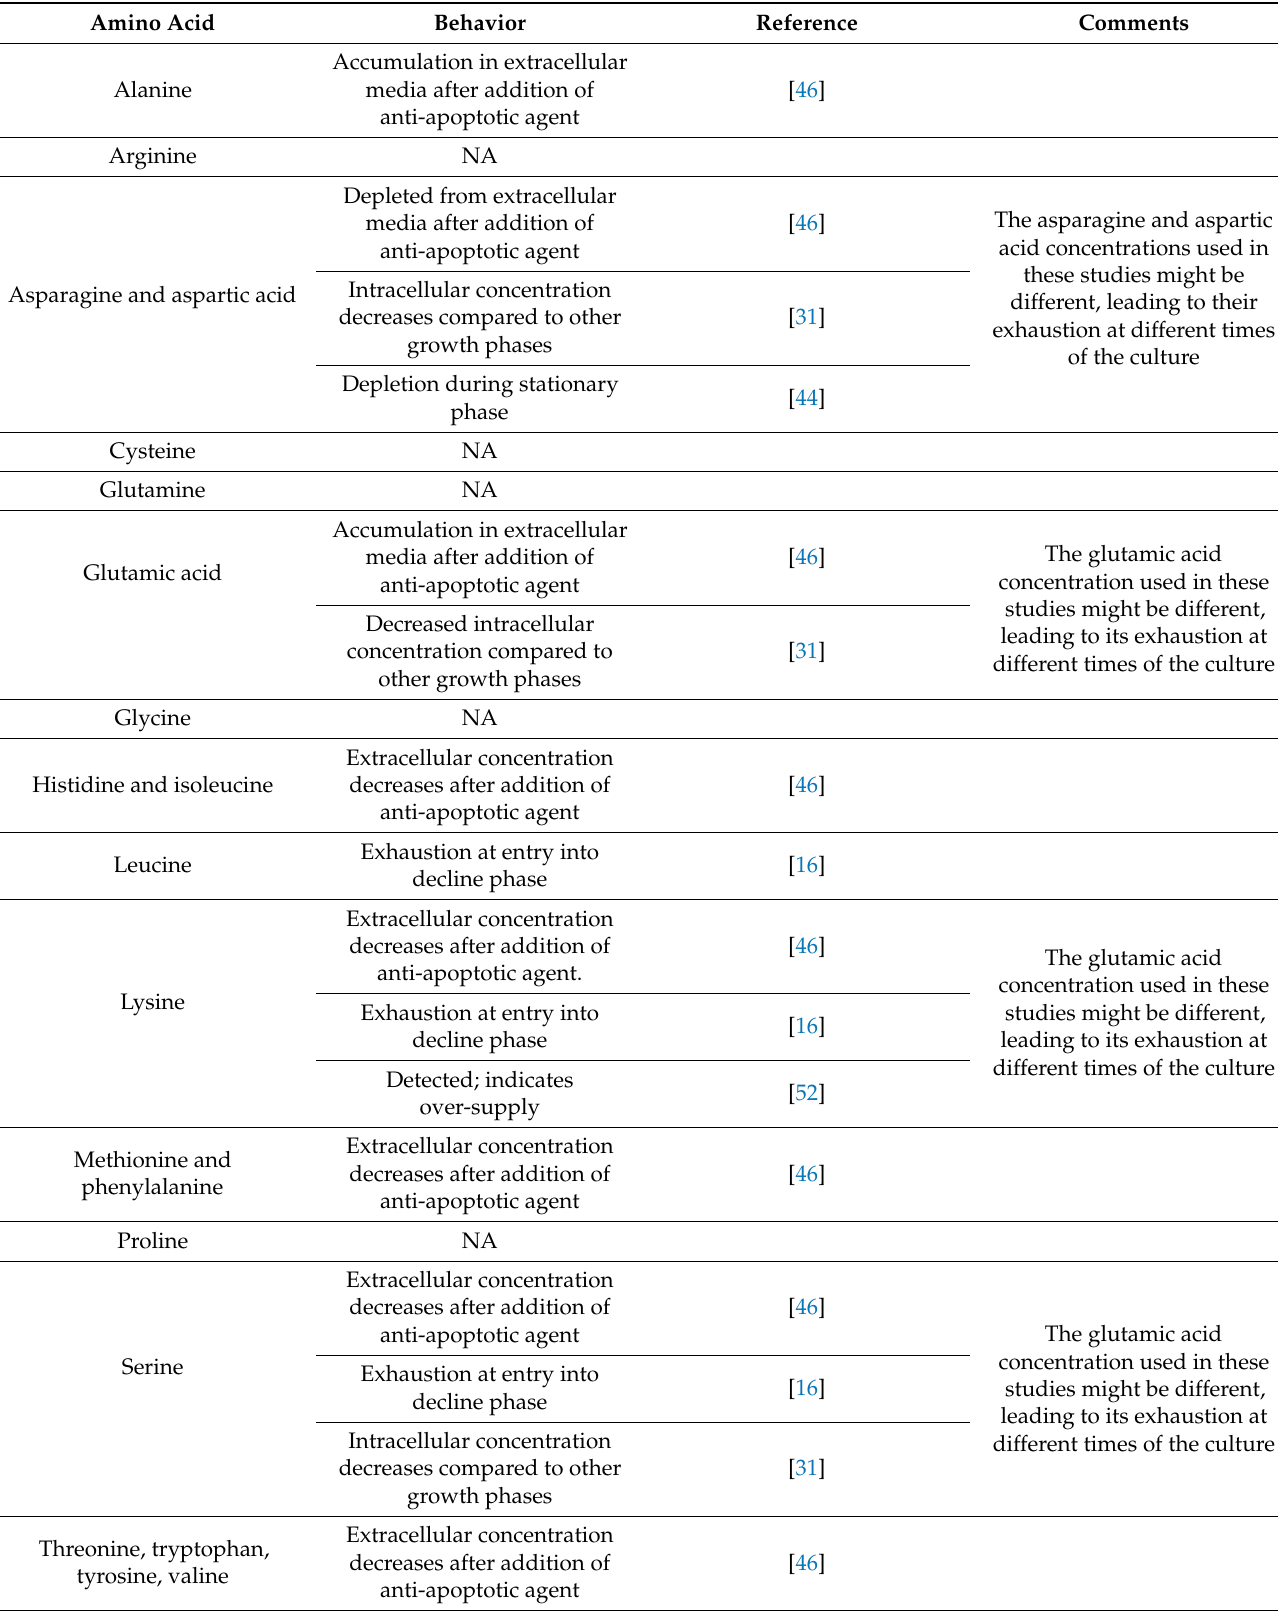
Table 3. Amino acids and amino acids derivatives at the decline